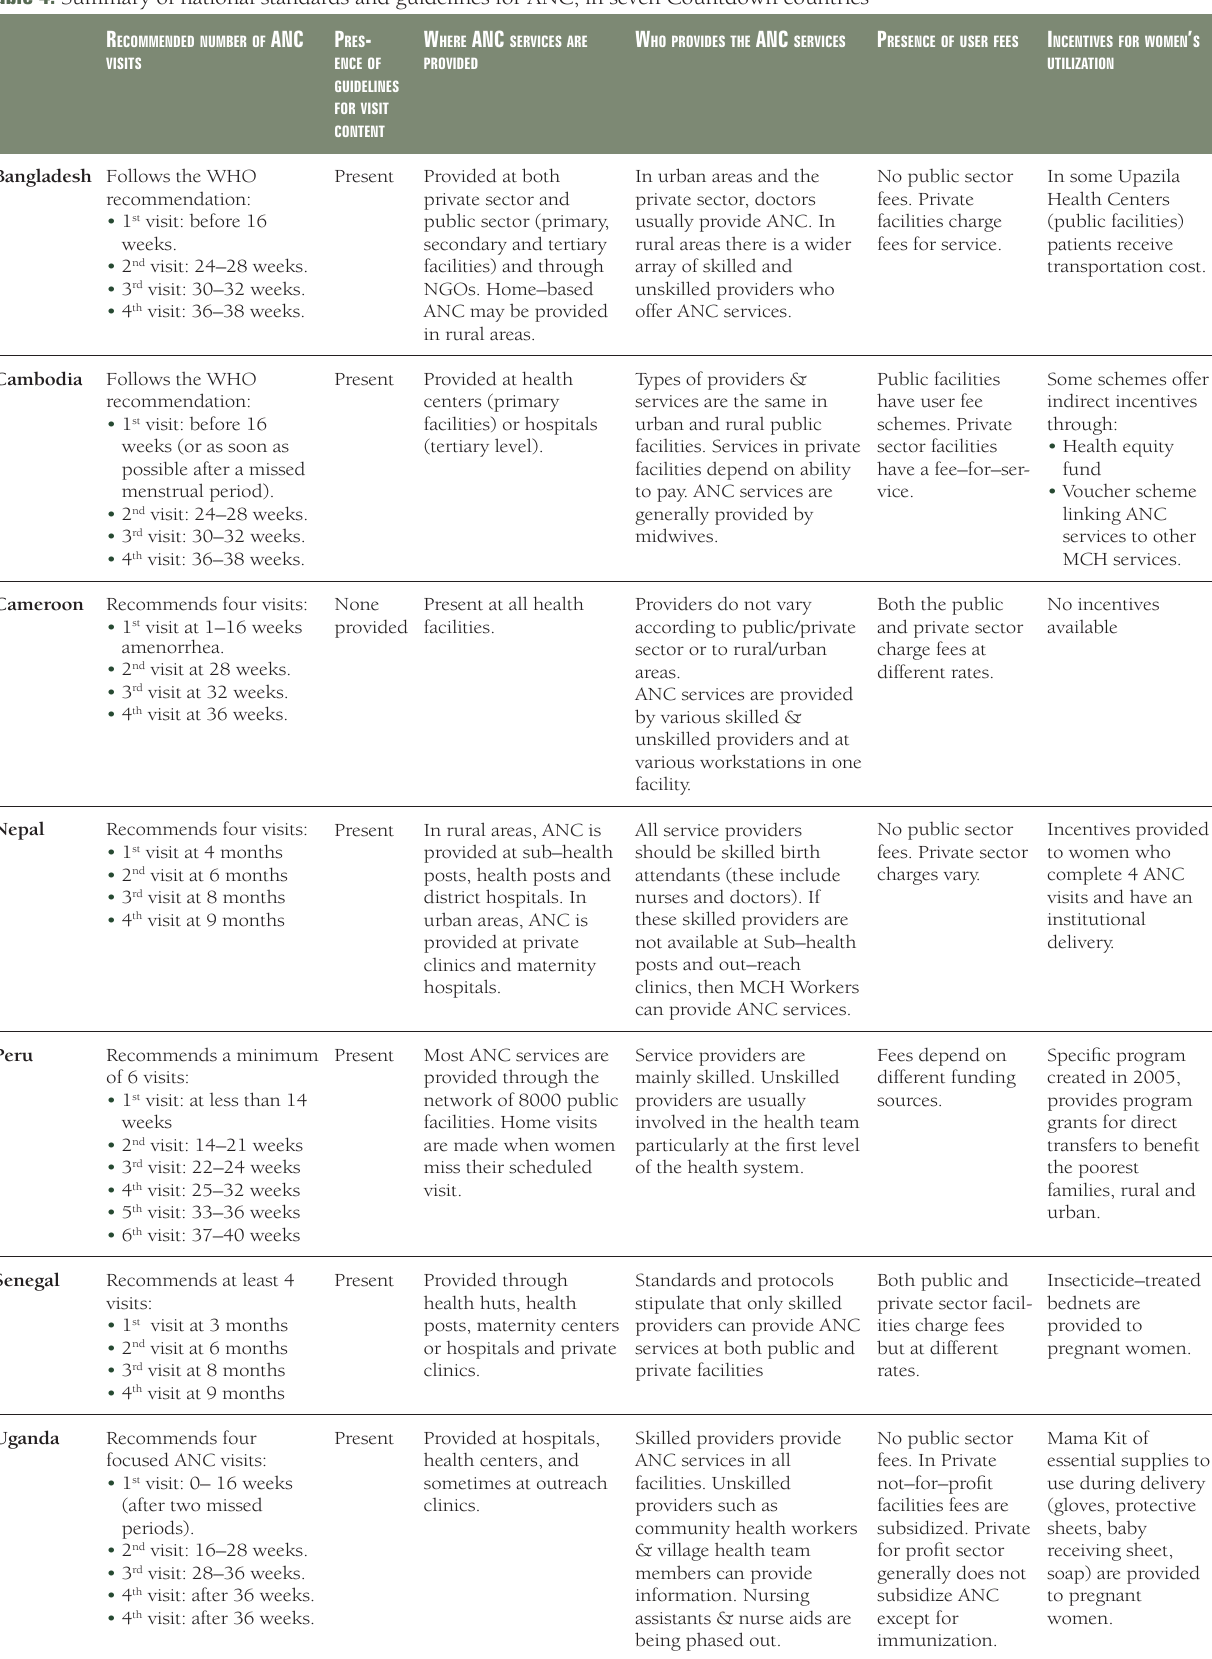
Table 4. Summary of national standards and guidelines for ANC, in seven Countdown